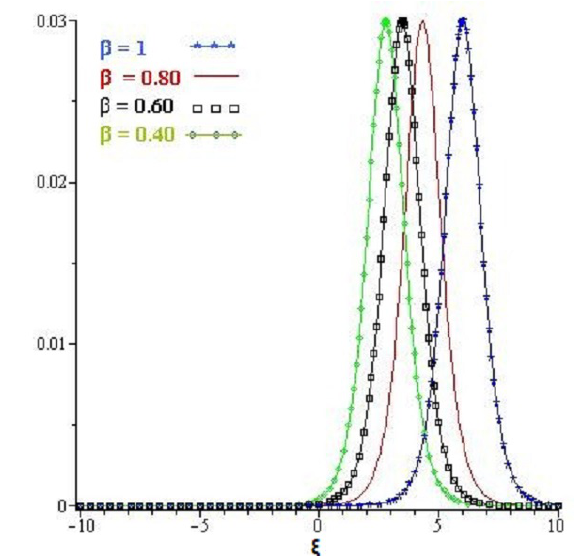
Figure 4. Variational homotopy perturbation transform method solution of example 4.2 at different fractional order β = 1, 0.8, 0.6,